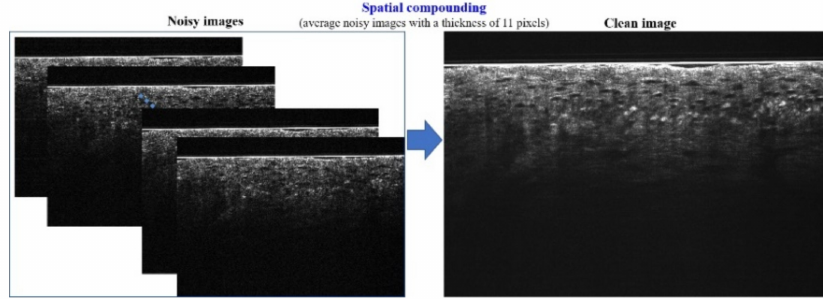
Figure 3. Schematic diagram of how to generate low-speckle ground truth images.